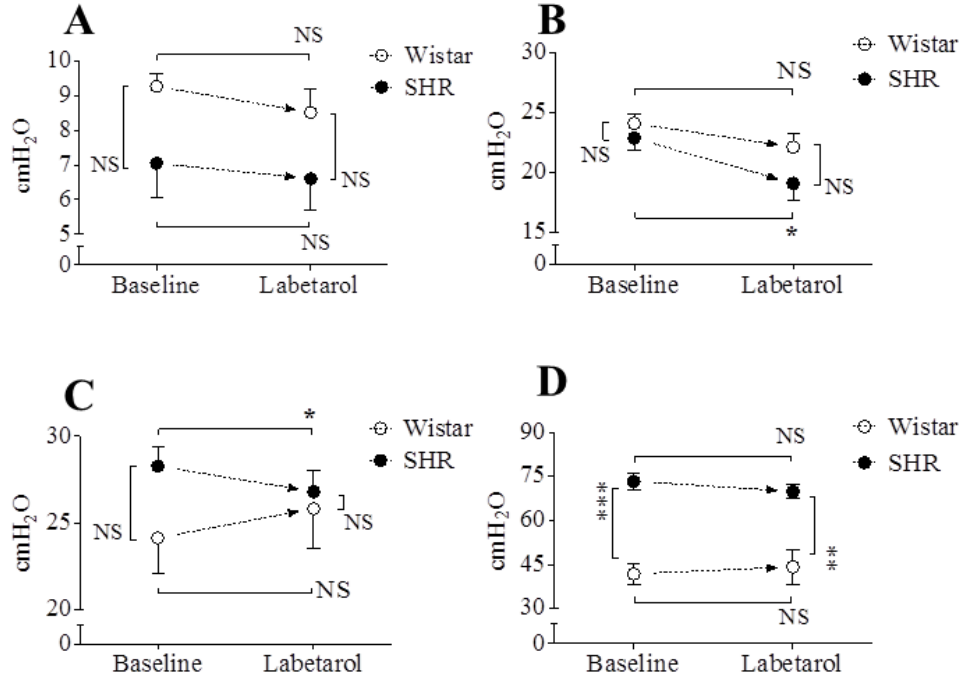
Figure 3. The effects of intraarterial 5 mg·kg −1 labetalol on the pressure parameters in SHRs and Wistar rats. ( A ) Basal pressure by detrusor pressure (DP); ( B ) Flow pressure; ( C ) Threshold pressure by DP; ( D ) Micturition pressure by DP. Results are expressed as mean ± standard error of the mean. * p < 0.05, ** p < 0.01 (unpaired Student’s t -test). NS: not significant.